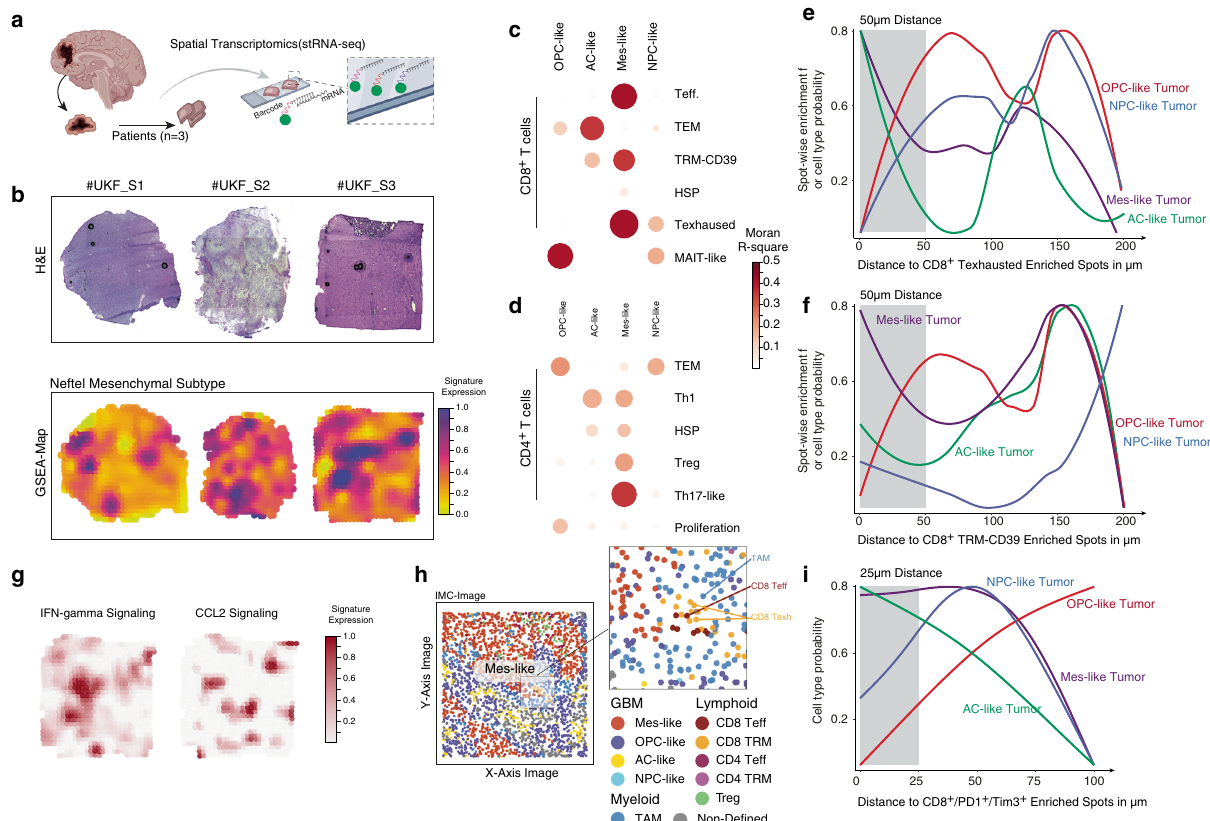
Fig. 4 Spatial analysis of T cell distribution in glioblastomas. a Illustration of the work fl ow using spatially resolved transcriptomics (stRNA-seq). b Histological images (H&E), upper plot, and surface plots of the gene set enrichment of the mesenchymal-like signature ( n = 3 patients) c , d Spatial correlation analysis with Moran statistics ( R 2 -values) between the GBM subtypes and CD8 + T cell clusters ( c ) and CD4 + T cells ( d ). Point size and color indicate spatial correlation. e , f Line plots illustrate the distance between the CD8 + clusters (TRM-CD39 ( e ) and T exhausted ( f )) and tumor subtypes. The x-axis represents the cell type probability computed by gene set enrichment analysis of de fi ned gene sets based on subtype. The y-axis represents the spatial distance to de fi ned T cell clusters based on ranked SPOTlight probabilities. g Surface plot of the IFN-gamma and CCL2 response in the S3 tumor sample. h Imaging mass cytometry (IMC) data from a GBM sample with annotated cell types. i Spatial distance between tumor subtypes and exhausted CD8 + cells from IMC